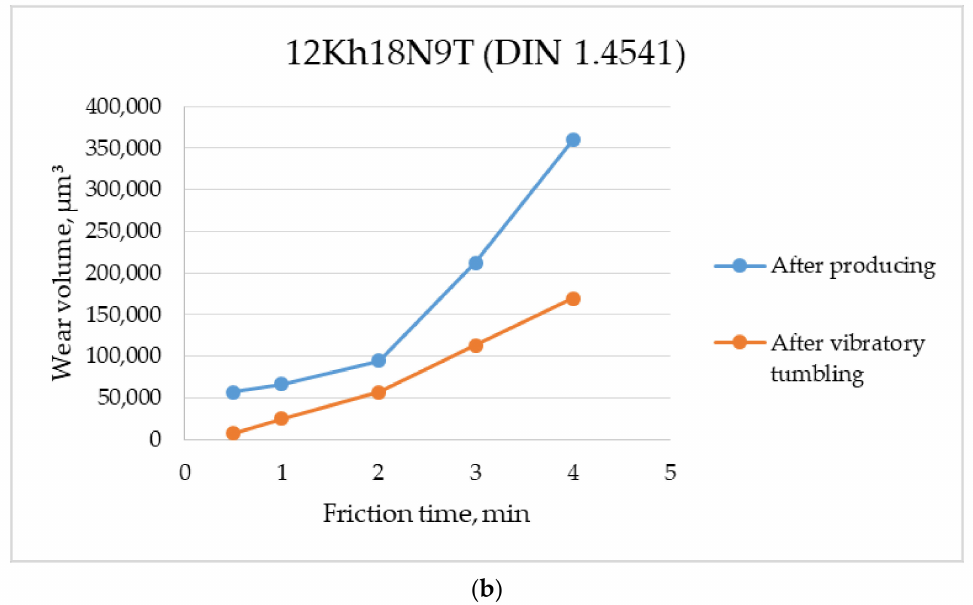
Figure 9. Dependence of the wear rate on the friction time: ( a ) for 20Kh13 (DIN 1.4021) steel samples; ( b ) for 12Kh18N9T (DIN 1.4541) steel samples.